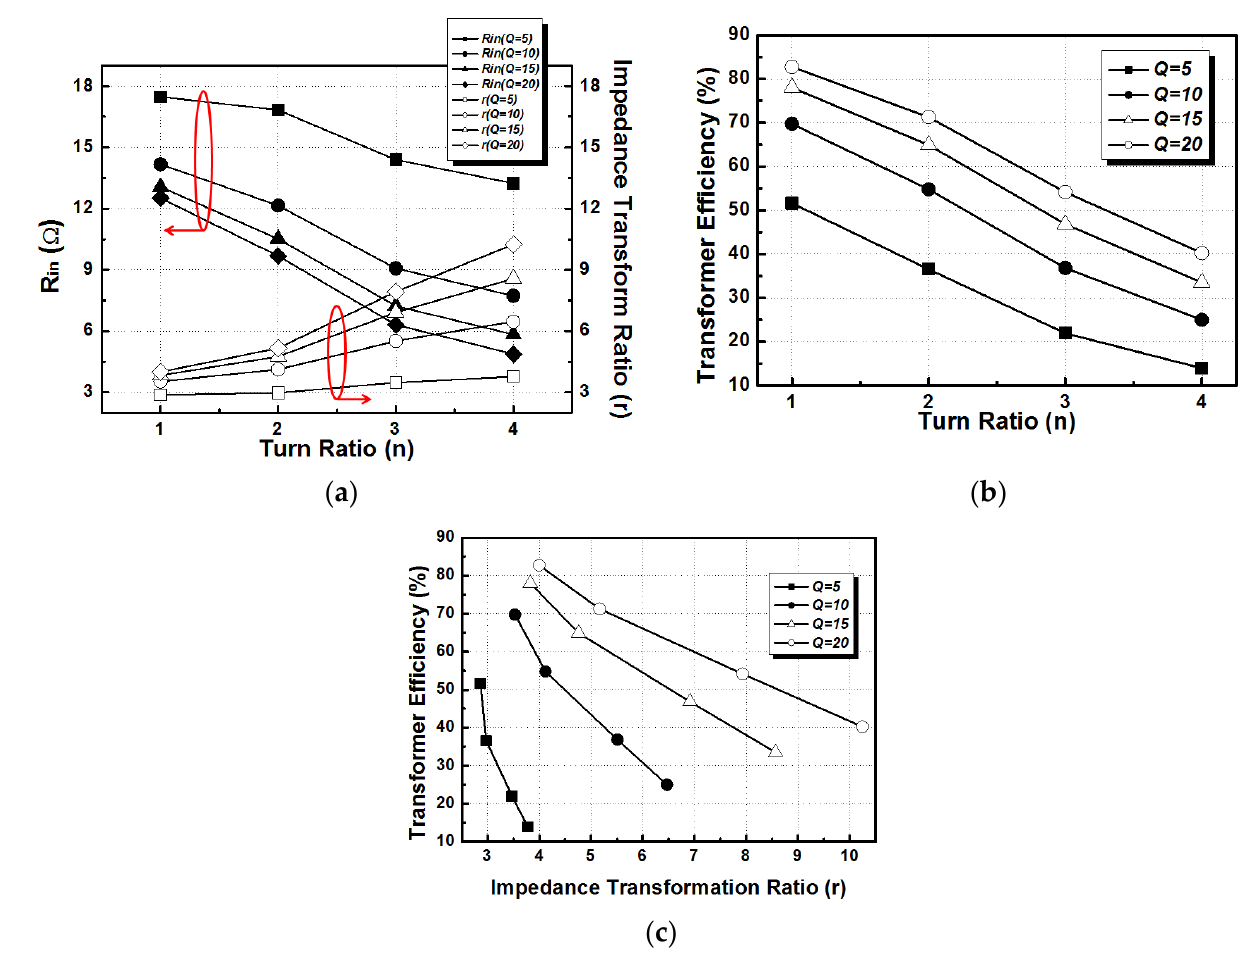
Figure 16. ( a ) R in vs. turn ratio and impedance transform ratio vs. turn ratio. ( b ) Transformation efficiency vs. turn ratio. ( c ) Transformation efficiency vs. impedance transformation ratio.